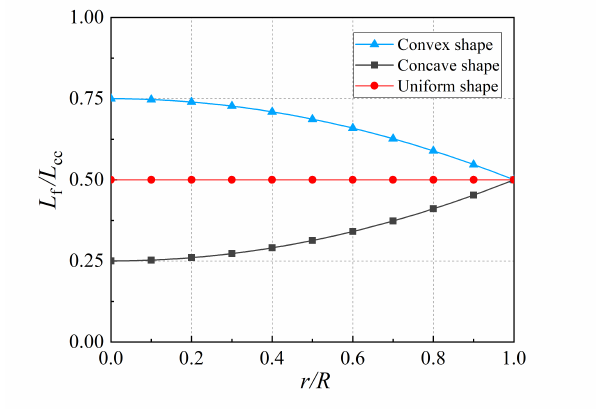
Figure 5. Flame lengths as a function of the radius r for the three kinds of distribution